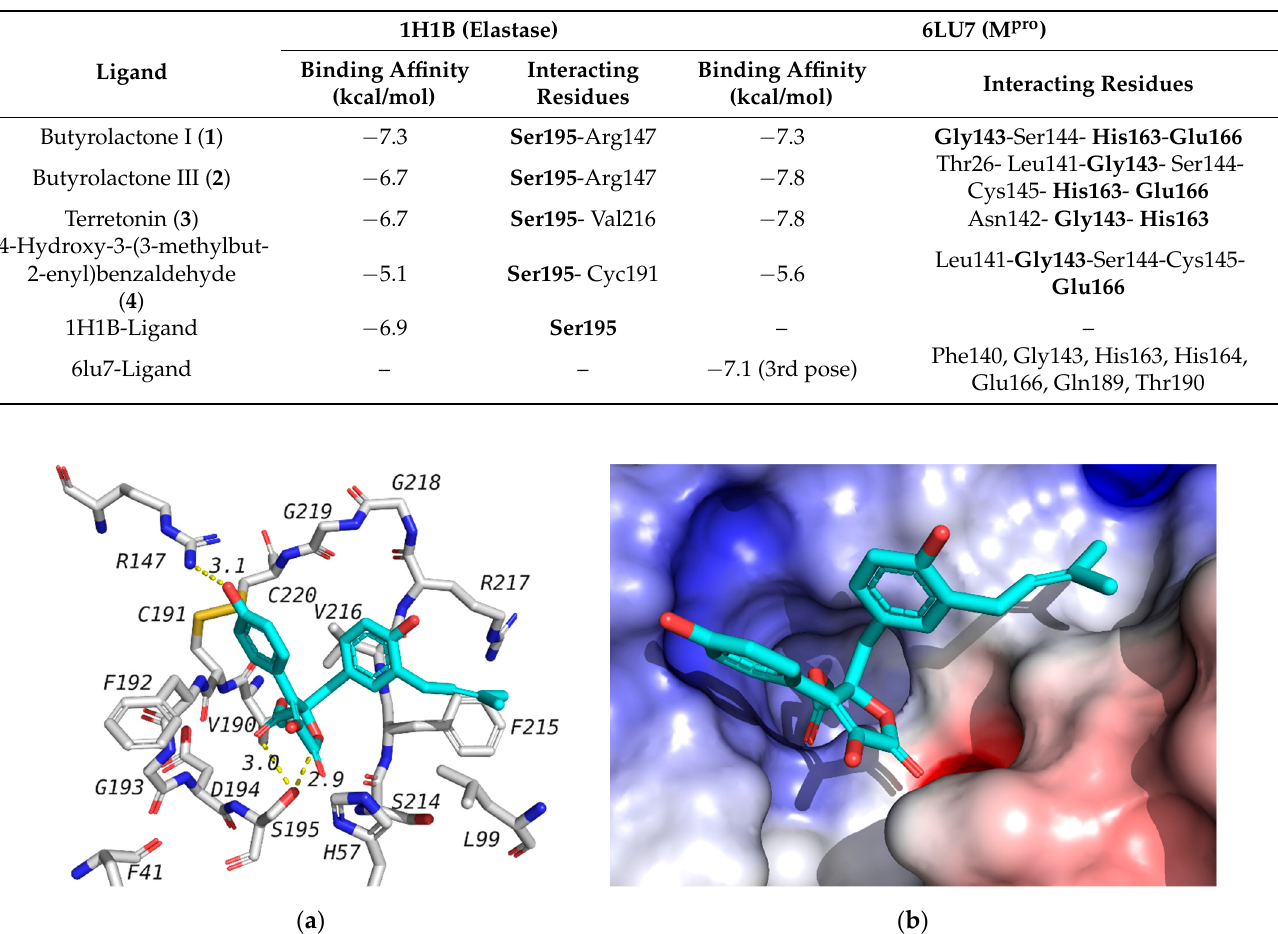
Table 3. Docking results of tested compounds in the active sites of human NE (1H1B) and SARS-CoV-2 main protease (6LU7). Amino acids’ interactions with both the co-crystalized ligands and tested ligands are shown bold.